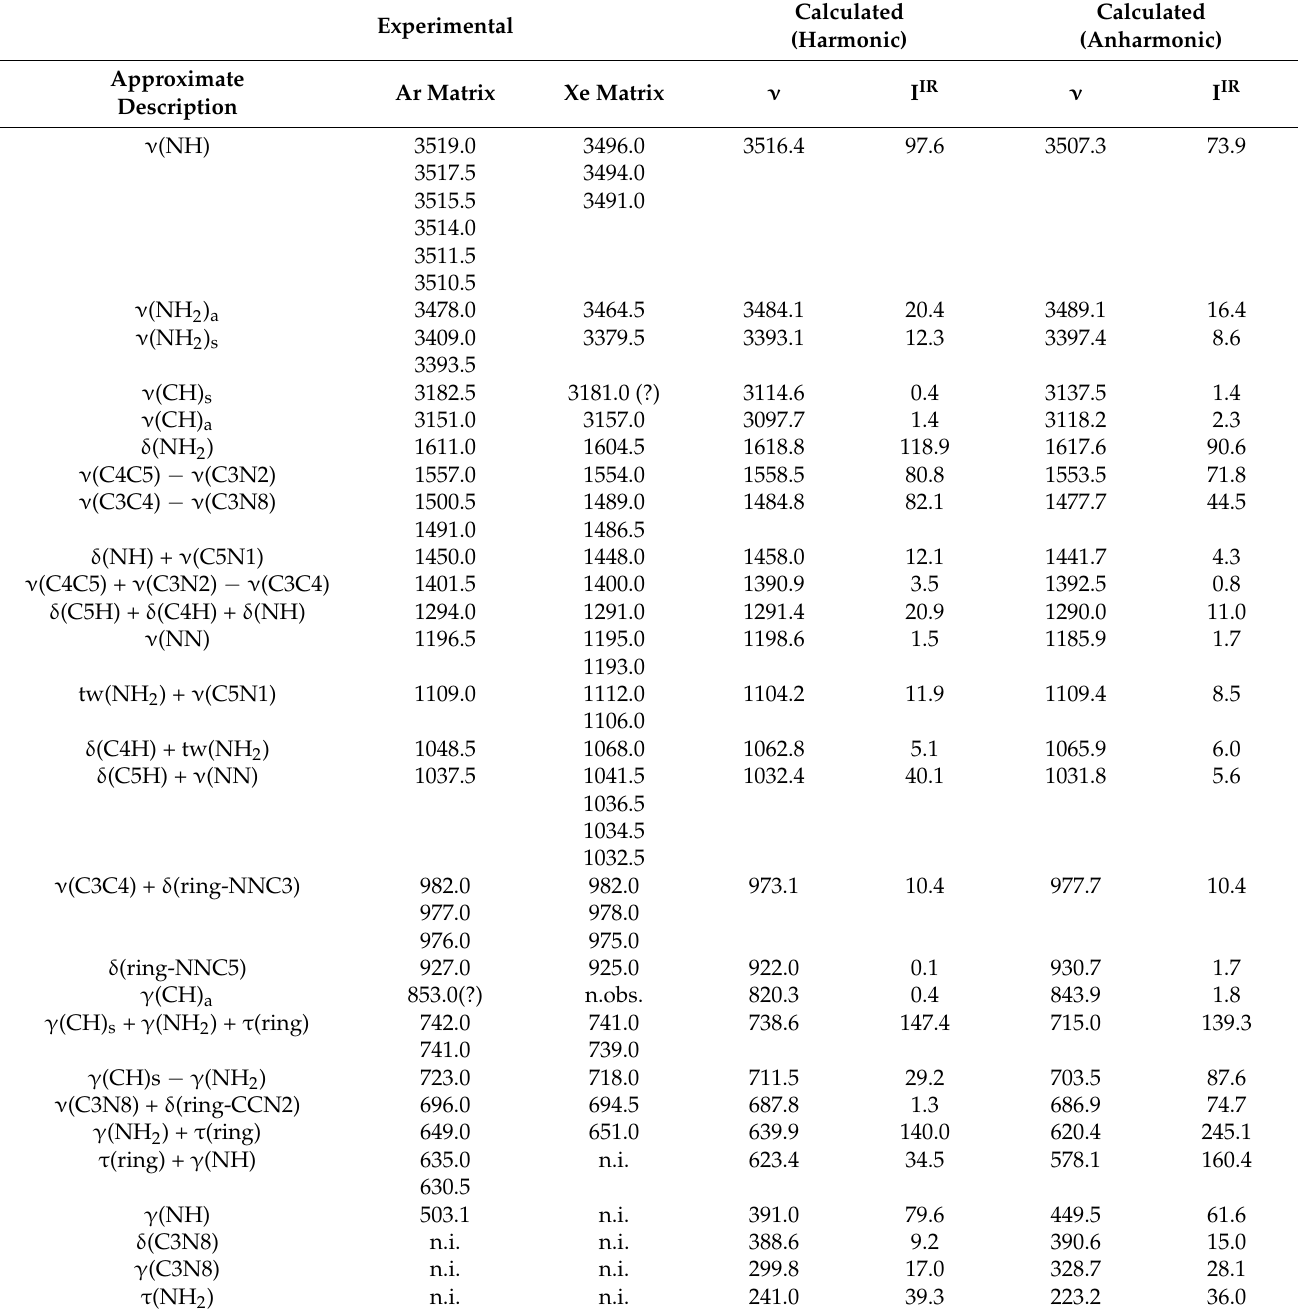
Table 2. Experimental IR bands assigned to 3AP isolated in Ar and Xe matrices and DFT(B3LYP)/6-311++G(d,p) calculated IR data for 3AP, with tentative assignments a